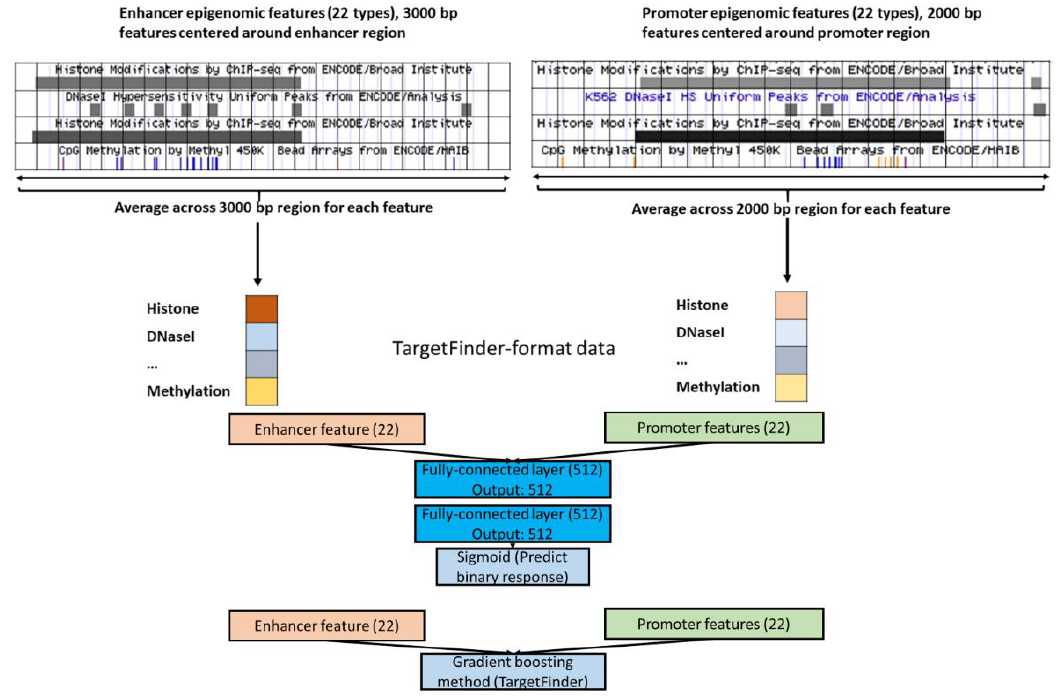
Figure 4. TargetFinder-format (epigenomic) data and the feed-forward neural network (FNN) model structure.